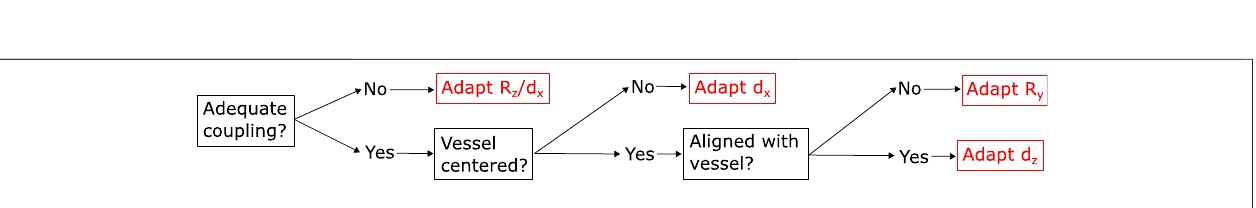
FIGURE4| StructureoftheDC-Netwithfourconvolutionallayers,eachdirectlyfollowedbyaleakyReLulayerandanisotropicmaxpooling.The fl attenedoutputof the fi rst four layers is further processed through two dense layers, including an in-between ReLu and dropout layer ( p = 0.5) and a fi nal softmax layer for binary classi fi cation into coupled (0) and decoupled (1).